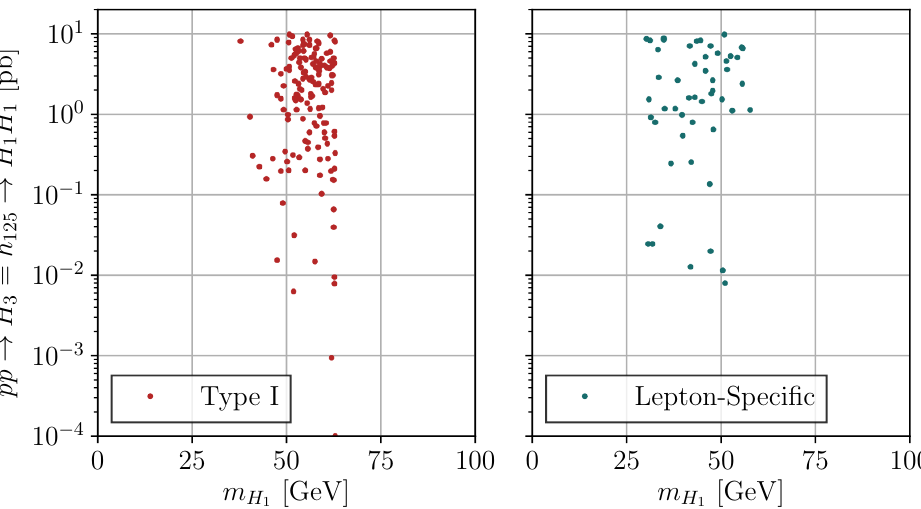
Figure 8 . Rate for pp for Lepton-Speci(cid:12)c